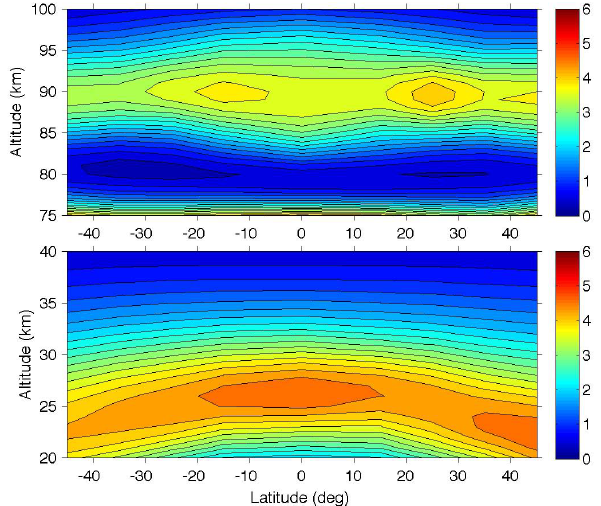
Fig. 10. The constant factor c(z) in the O 3 time series as a function of latitude and altitude. Upper panel: MLT with the scale 10 8 cm − 3 . Lower panel: Stratosphere with the scale 10 12 cm − 3 .